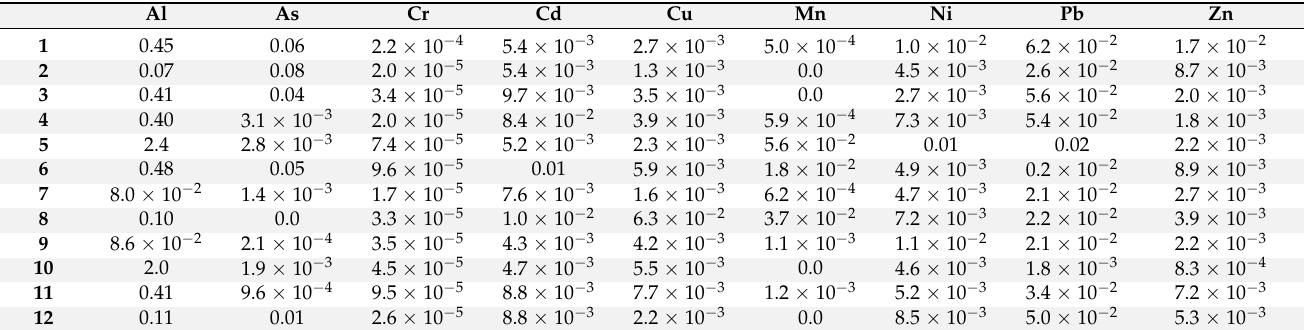
Table 4. HQ scores obtained for the studied water samples if